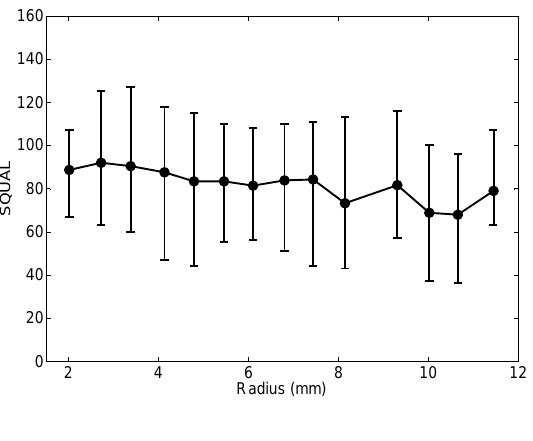
Figure 9. Average, maximum and minimum value of the SQUAL register obtained in one rotation of a two-Euro coin with the optical sensor placed at different